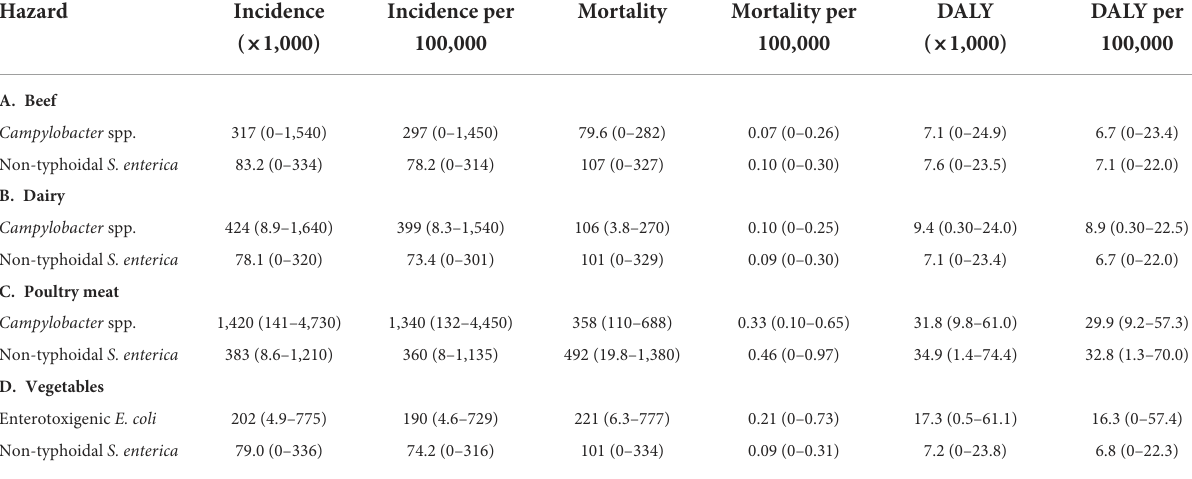
TABLE 6 Disease burden associated with specific food consumption in Ethiopia in 2017 (total population). Incidence ( ×